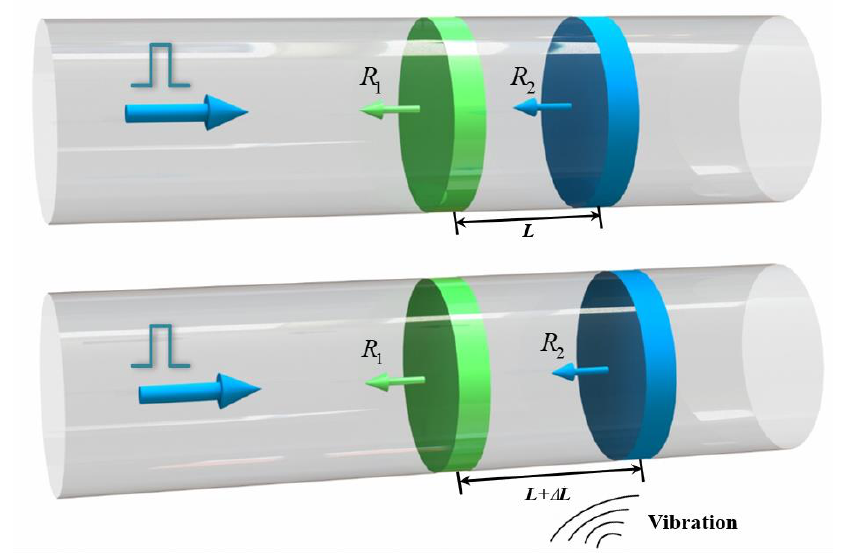
Figure 1. Schematic of strain and phase change caused by external vibration.